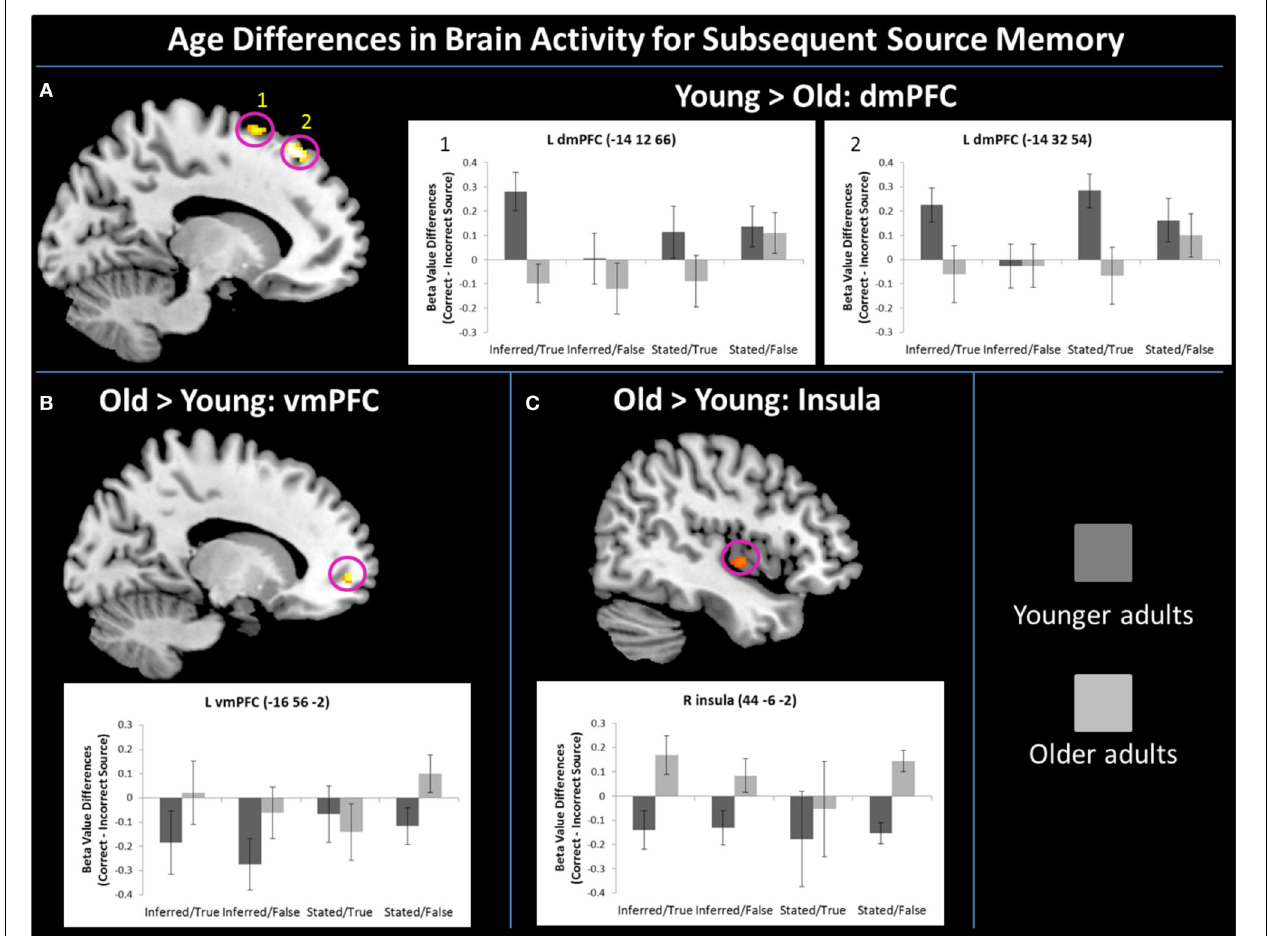
FIGURE 2 | Agedifferencesforcorrect—incorrectsourcememoryfortruth value existed in mPFC, such that young adults had enhanced activity over older adults in two regions of left dmPFC (A), while older adults had